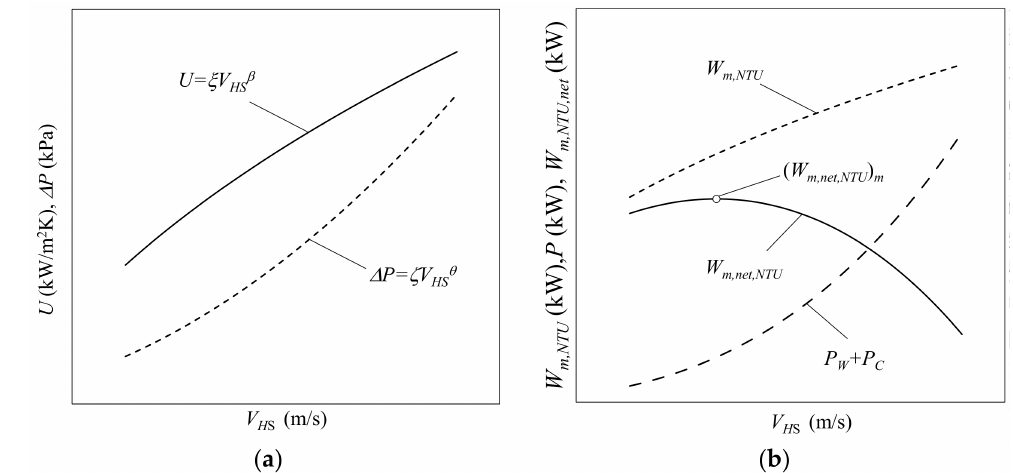
Figure 4. Concept of performance evaluation of a heat exchanger as a function of mean velocity of the heat source. ( a ) an overall heat transfer coefficient and a pressure drop; and ( b ) a maximum power